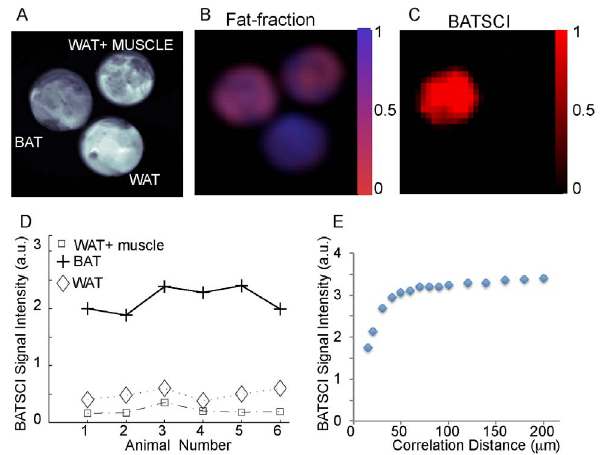
Figure 2. In vitro detection of excised mouse BAT. ( A ) Axial image of three samples containing BAT, WAT, and a mixture of WAT and muscle. ( B ) Fat fraction as measured by a conventional CSI sequence showing similar water content for the BAT and for the mixed sample. ( C ) BATSCI image showing the presence of a strong signal only in the BAT sample. ( D ) BATSCI signal normalized to the nearby fat-fat iZQC signal from different tissues and from different mice. ( E ) BATSCI signal intensity as function of the correlation distance as obtained from